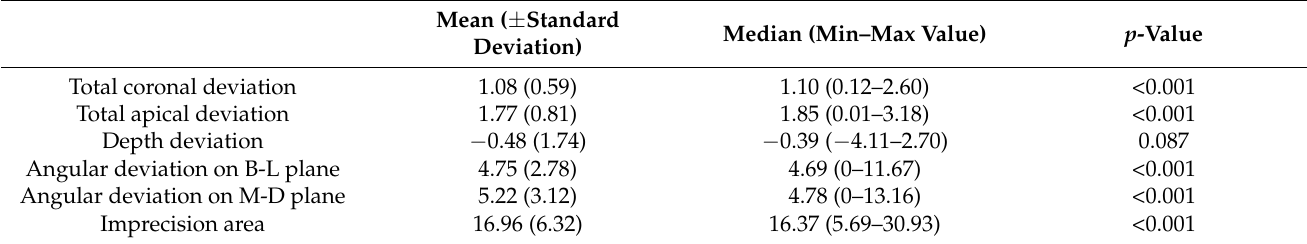
Table 1. Summarized statistical analysis of the examined accuracy